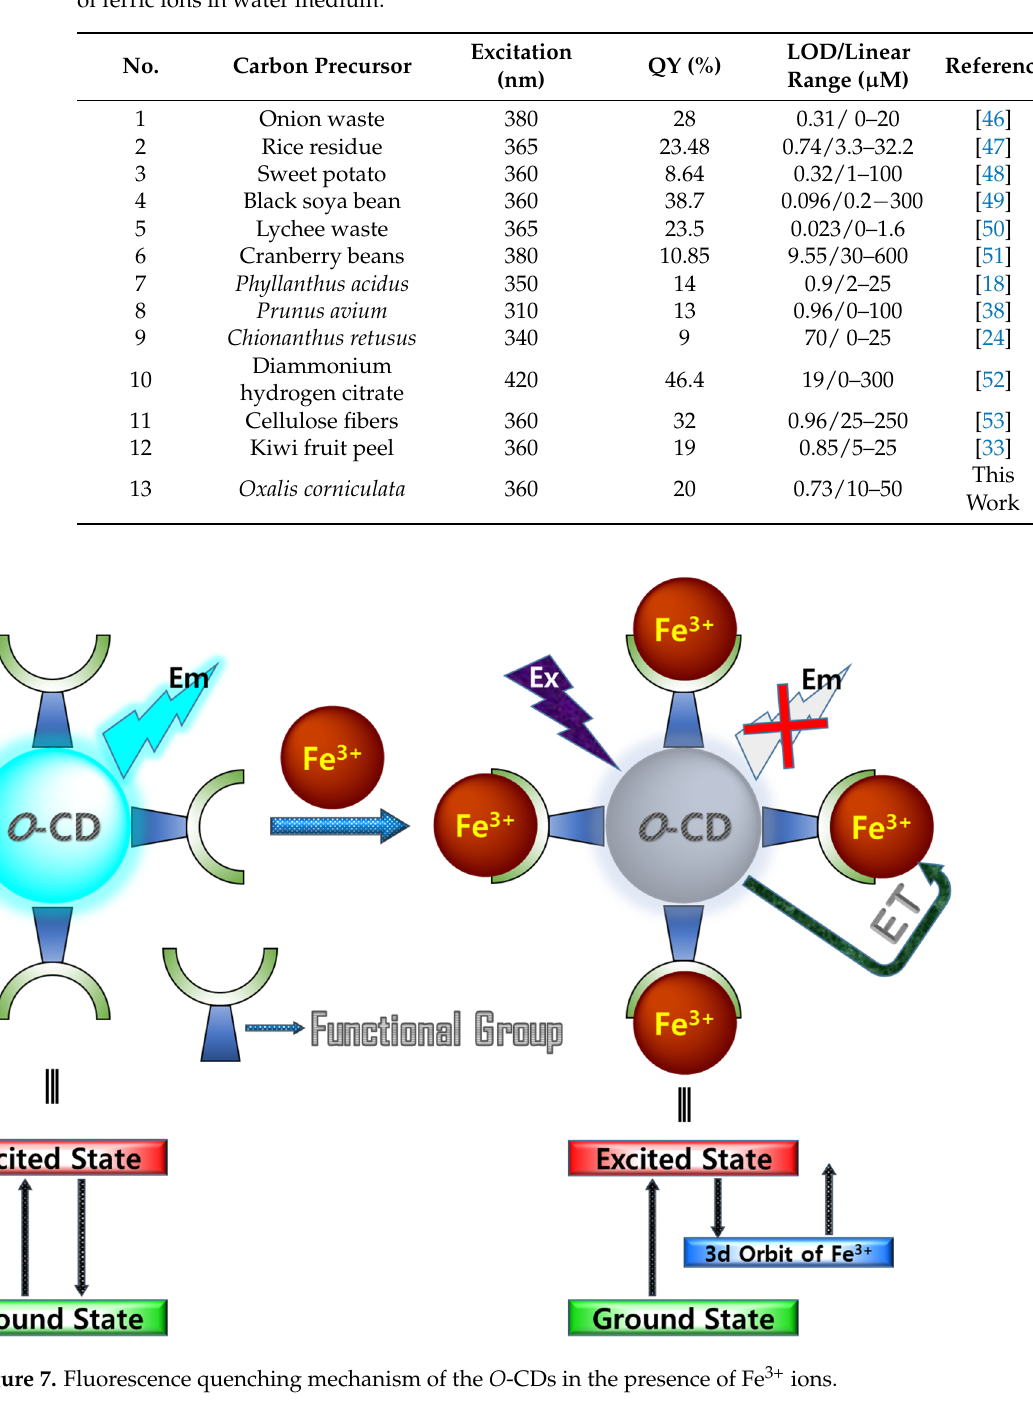
Table 1. Comparison of the different fluorescent sensors from natural sources for the selective sensing of ferric ions in water medium.